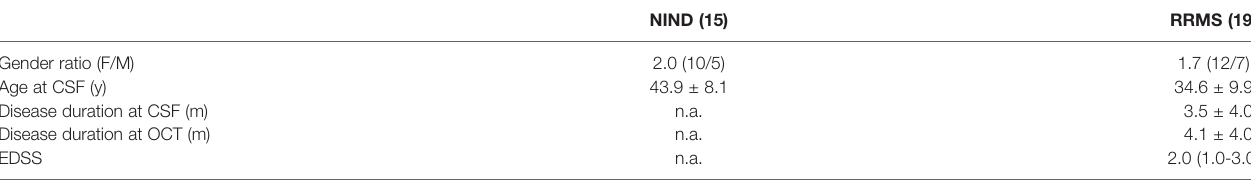
TABLE 1 | Clinical and demographic characteristics of